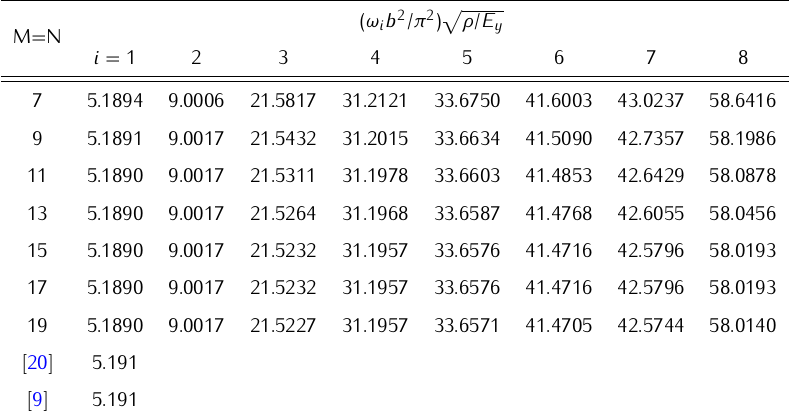
Table 2. Convergence study with respect to the results given by [20] and [9] for a cross-ply laminates ( for Boundary condition i.e. CSFF